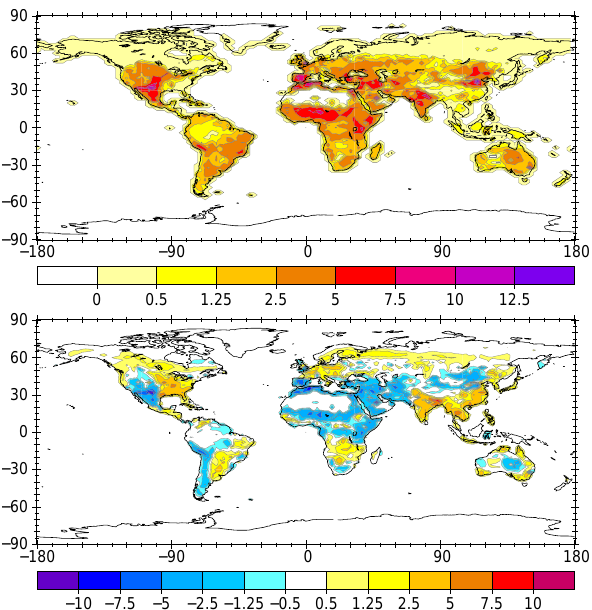
Fig. 11. Averaged SNO x flux for the year 2000 of the Jaegl´e et al. (2005) (J05) inverse modeling study (in ngm − 2 s − 1 ) (upper panel) and the difference between the YL95/SL11 year 2000 simulation and the J05 results (YL95/SL11 – J05) (lower panel).